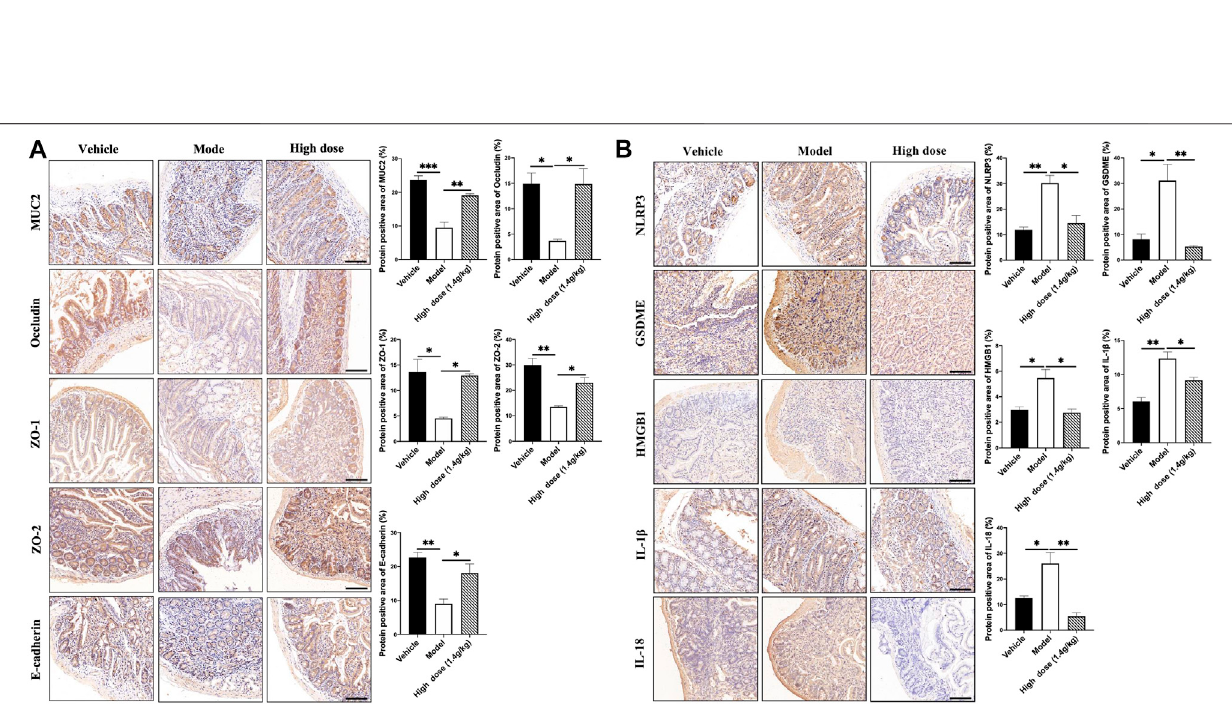
Frontiers in Physiology |